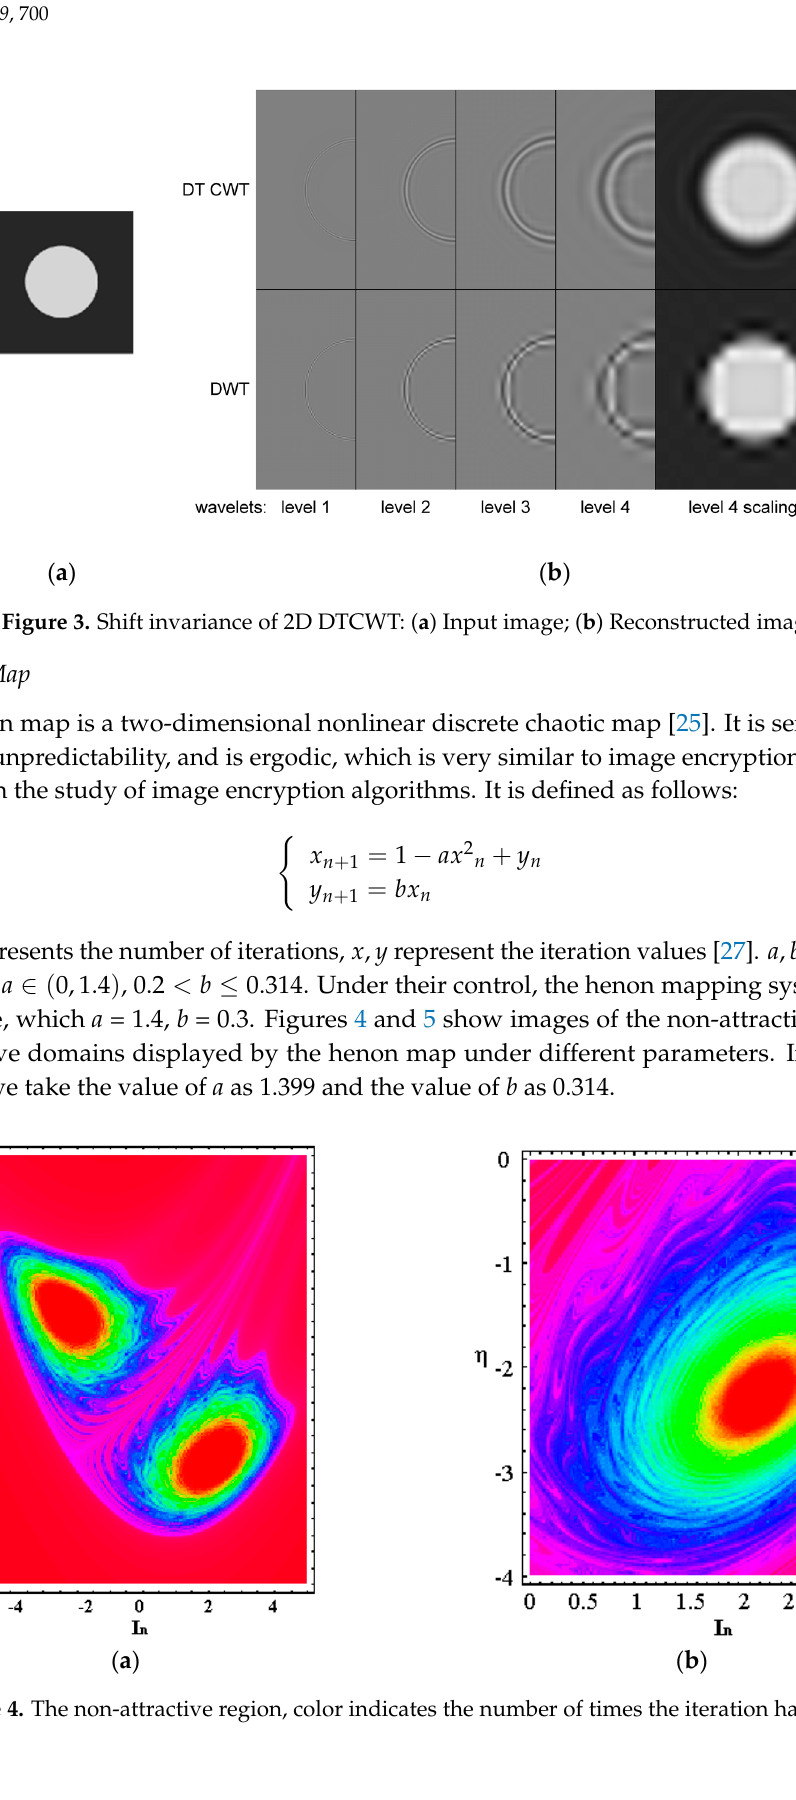
Figure 5. Two domain of attraction. 3. The Proposed Algorithm The proposed algorithm is based on DTCWT-DCT and a henon map. It is a multi-watermark scheme for medical images, which meets the requirements of zero watermark and blind extraction. It